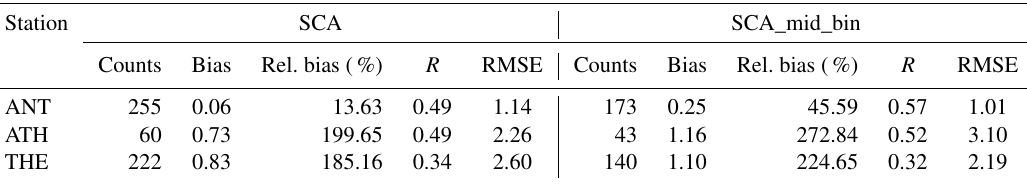
Table 1. Statistical metrics for the unfiltered (cloud plus aerosol) Aeolus L2A SCA and SCA mid-bin backscatter (in Mm − 1 sr − 1 ) profiles at each PANACEA